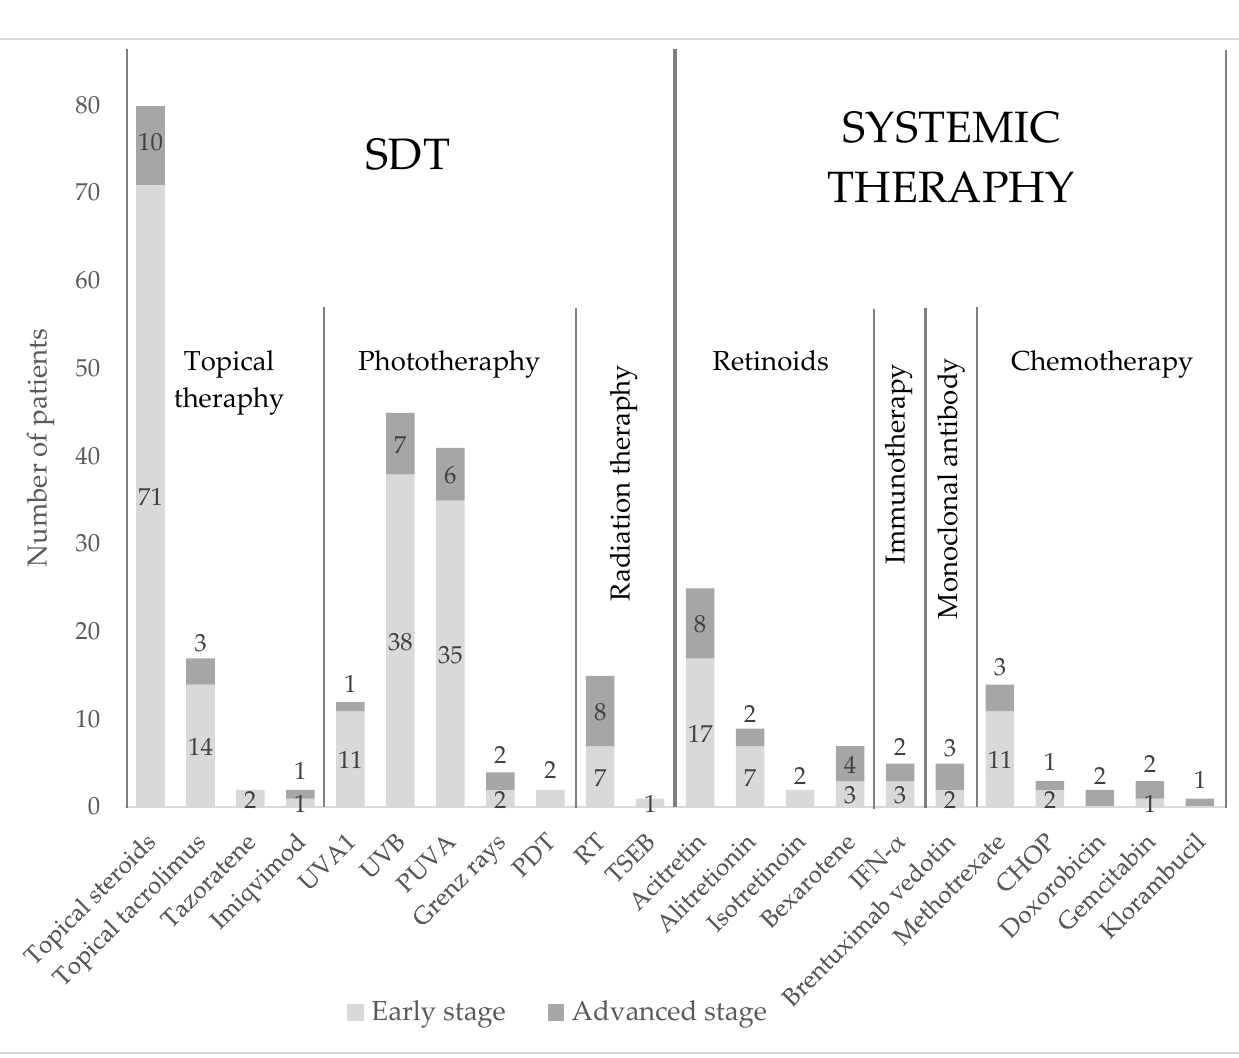
Figure 6. Overview of all treatments, with the digits in the bars presenting the number of patients treated for early-stage (light grey) and advanced disease (dark grey top). SDT: skin-directed therapy; UVA1: ultraviolet A 1; UVB: ultraviolet B; PUVA: psoralen plus ultraviolet A; PDT: photodynamic therapy; RT: radiation therapy; TSEB: total skin electron beam therapy; IFN- α : interferon-alpha; CHOP: cyclophosphamide, doxorubicin hydrochloride, vincristine sulfate, and prednisone. Topical tacrolimus was less used, accounting for 16.7% of the patients with early-stage disease and 3.6% of the patients with advanced-stage disease. Tazarotene and Imiquimod were the least used topical